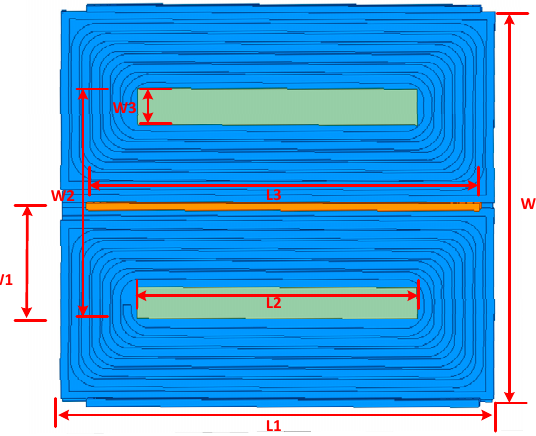
Figure 4. The top view of the coupling structure.